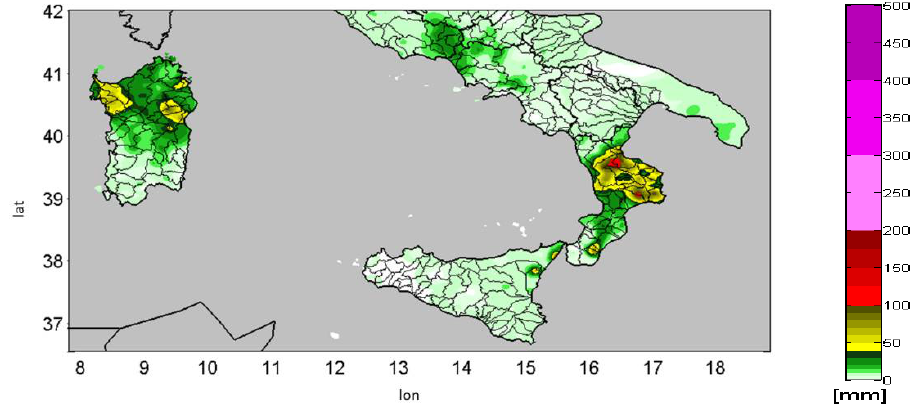
Figure A6. Example of GRISO interpolation of radar values sampled on rain gauge